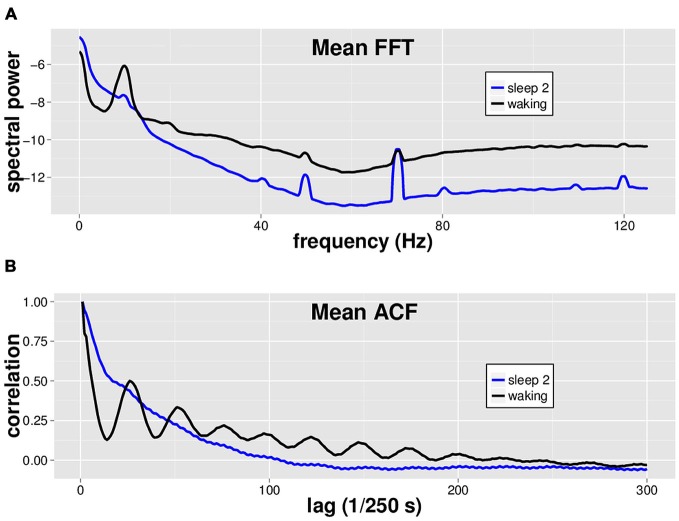
Mean spectral analysis and autocorrelation function analysis for waking vs. sleep stage 2 EEG. Fourteen subjects had 8 min each of both waking and sleep stage 2 EEG data, in non-continuous 1 min segments. (A) Fast Fourier Transform (FFT) was performed on 8 × 1 min segments of both waking (black) and sleep stage 2 (blue) EEG for each subject, and the spectra were averaged across segments and subjects to generate the mean spectrum shown. Waking EEG has more power in the alpha (8–13 Hz), beta, and gamma band (~20–40 Hz) ranges. (B) Autocorrelation function (ACF) with a maximum lag of 500 data points was performed on 8 × 1 min EEG segments of both waking (black) and sleep stage 2 (blue) EEG for each subject. Note characteristic oscillatory pattern for waking EEG ACF.